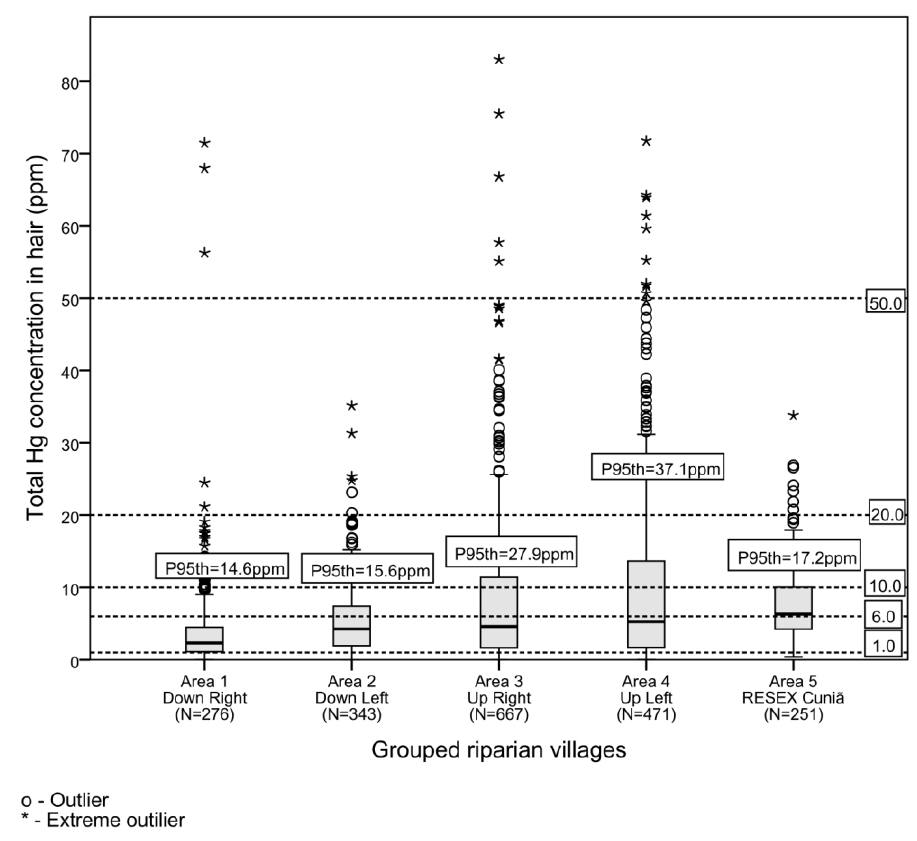
Figure 2. Box-plot representation of total hair-Hg concentrations in the studied population (ppm w/w = mg·kg −1